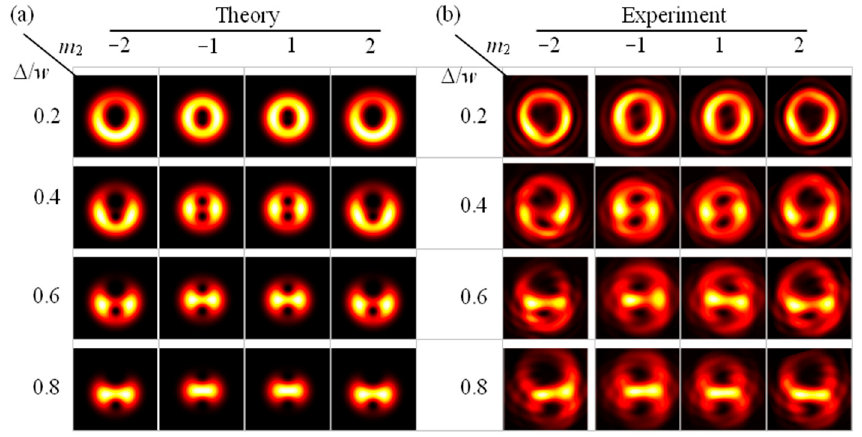
Photonics 2023 , 10 , x FOR PEER REVIEW 12 of 71 Figure 4. ( a ) Theoretically simulated and ( b ) experimentally measured intensity patterns of off-axis double vortex beams with different values of Δ and m 2 when w = 2.5 mm, x 1 = x 2 = 0, and m 1 = 1.